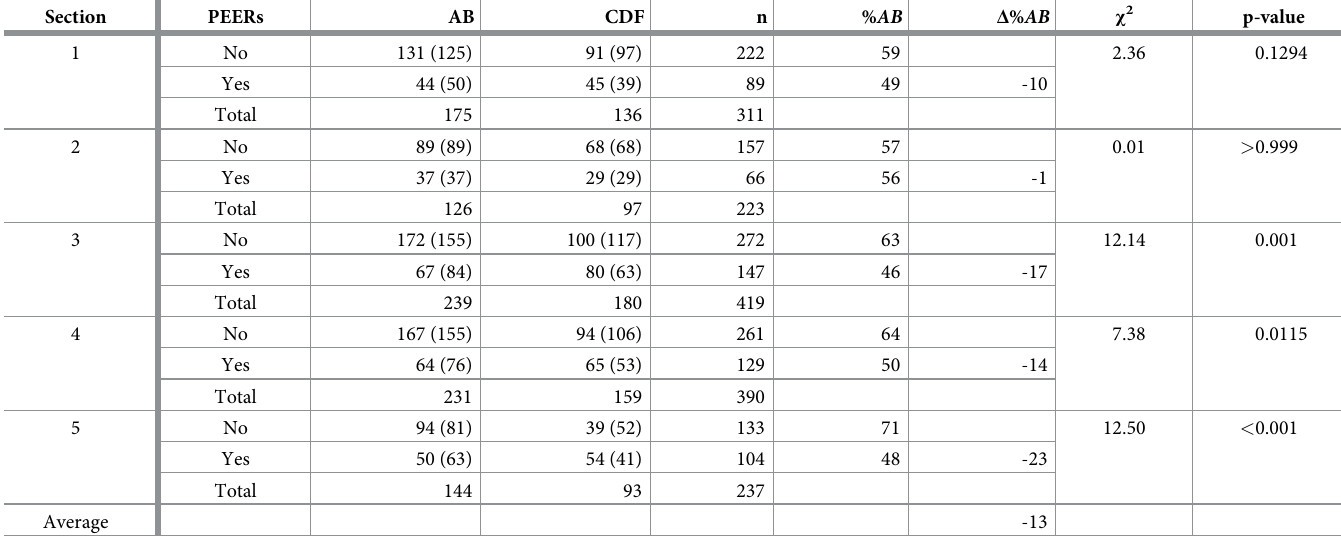
Table 1. Summary of the counts and proportion of students obtaining A and B grades versus C, D, and F grades for Instructor J across 5 sections of the same course. Section PEERs